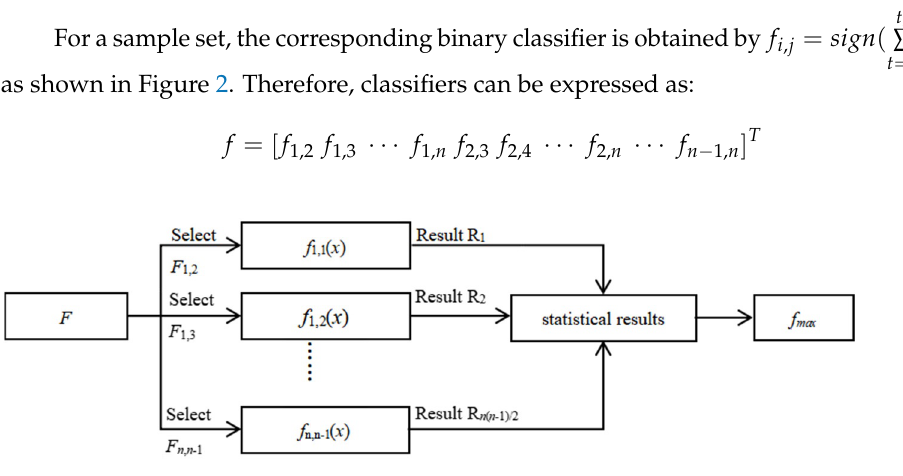
Figure 2. BFS extraction process based on AdaBoost, where F , F i , j , f i , j ( x ), R i , and f max are the classifier set, the binary label sample set, the binary classifier, the classification result, and the BFS of output, separately.